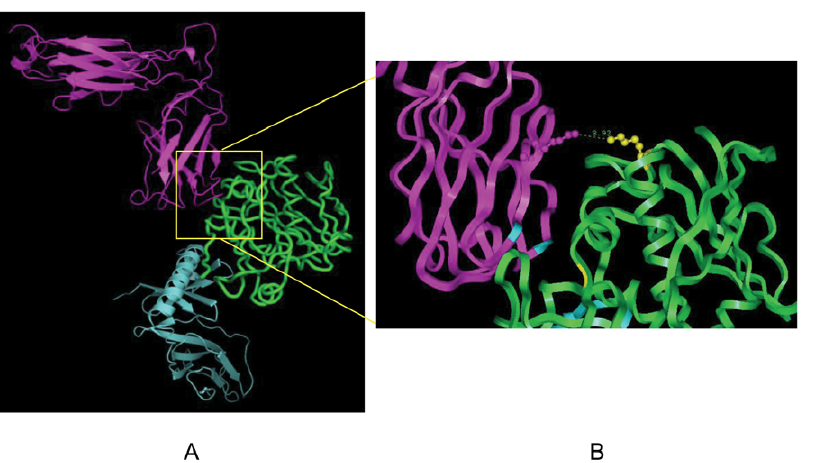
Figure 1. Structure of the MHC II-SEB-TCR complex. (A) The predicted model of the MHC II-SEB-TCR ternary signaling complexes. The structural complex is shown in the cartoon, SEB is colored in green, TCR is colored in magenta, and MHC II is colored in aquamarine. (B) Close views of interactions between SEB K173 and TCR K66. The two residues are shown as sticks and balls. SEB K173 is depicted in yellow and TCR K66 is depicted in aquamarine color. The distance between the two residues was 8.93 A˚.